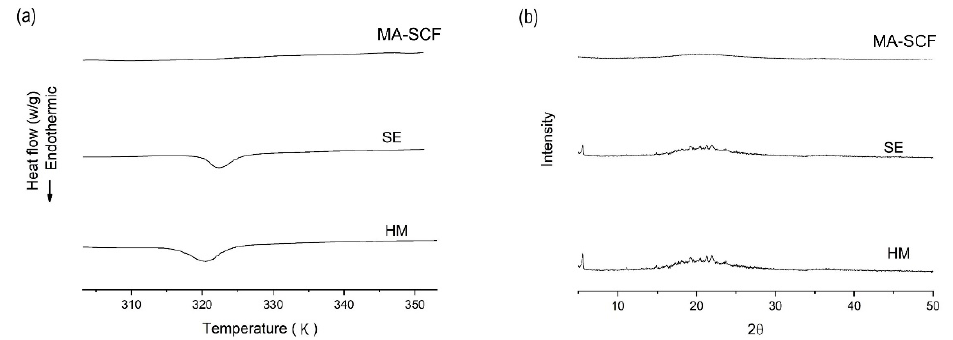
Figure 13. ( a ) DSC thermograms ( b ) and PXRD patterns for raw materials and orlistat-loaded Neusilin ® UFL2 samples prepared by various amorphisation